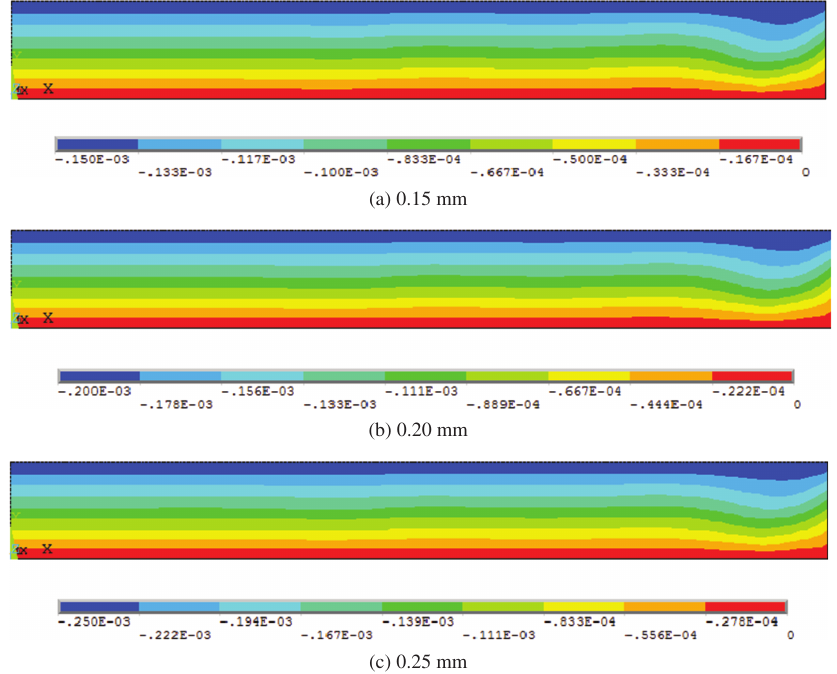
Figure 4: Displacement nephogram along thickness direction of slab under different reduction amounts.